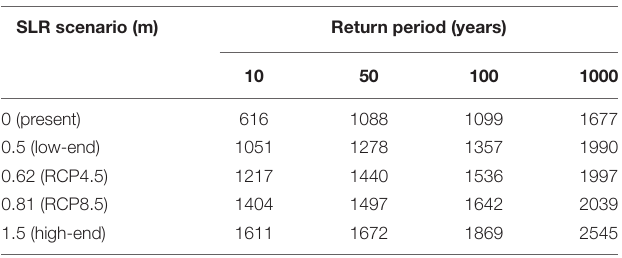
Frontiers in Marine Science |